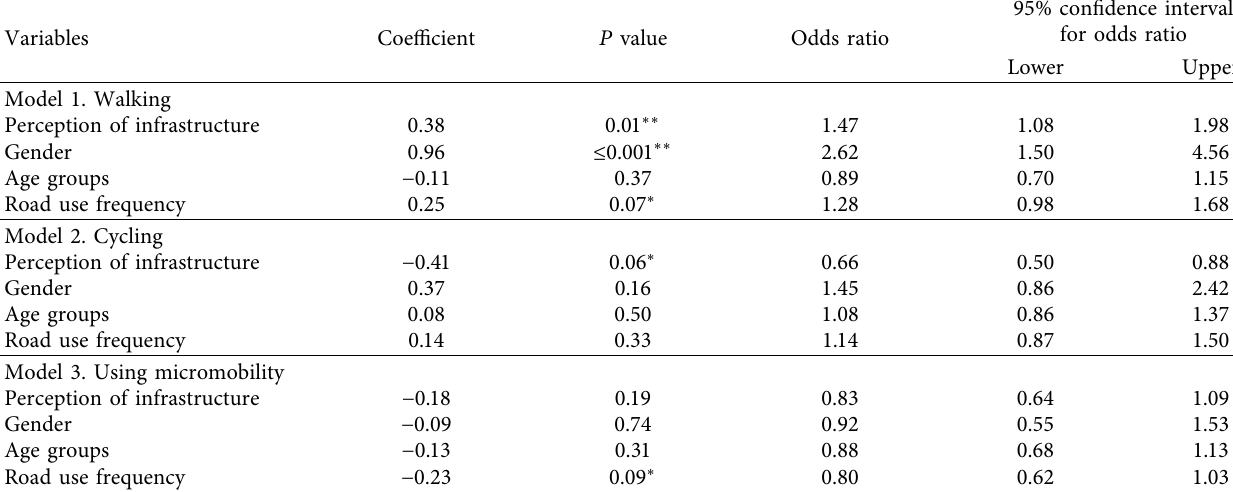
Table 5: Ordered logit models for chaos perception.